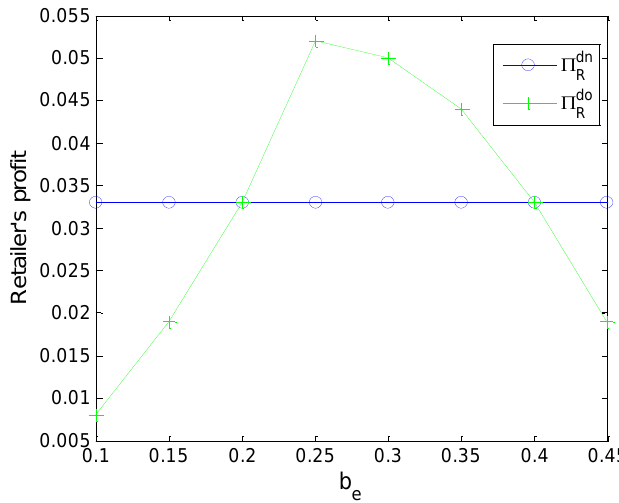
Figure 7. Impact of 𝑏 𝑒 on retailer’s profits under competition case.